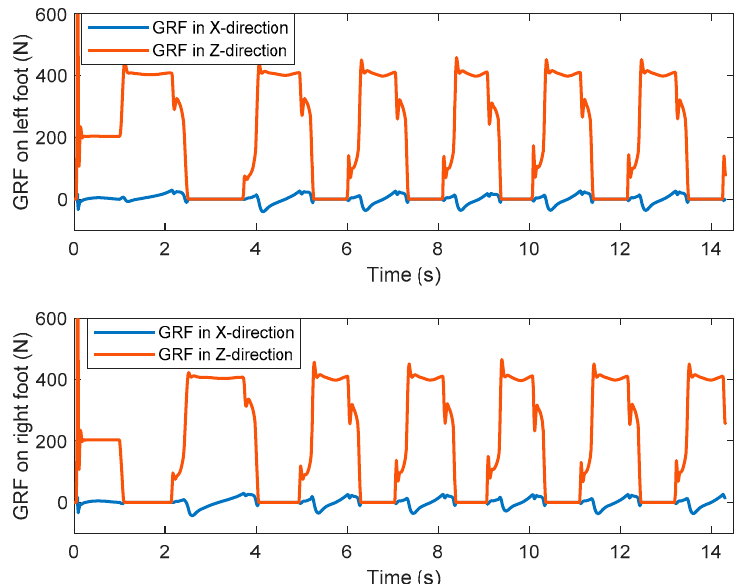
Figure 19. The ground reaction forces of the left and right feet in the first simulation.